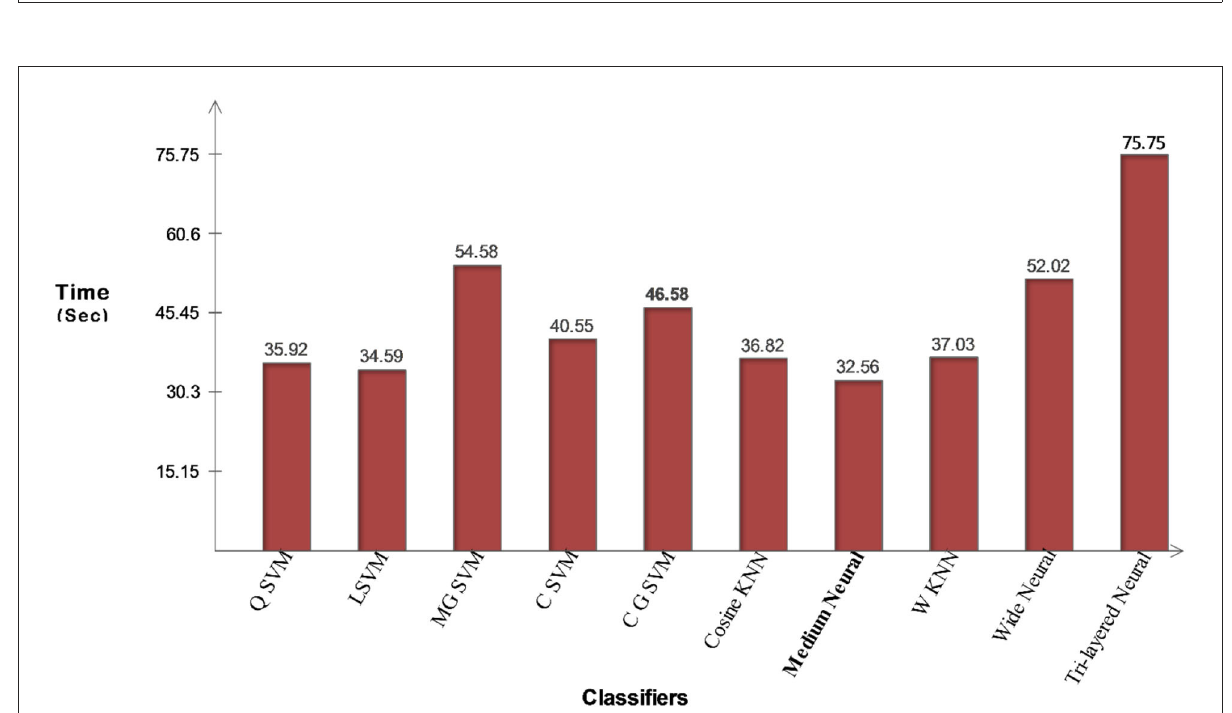
FIGURE17 Illustration of computational time for chest X-ray dataset using proposed optimization